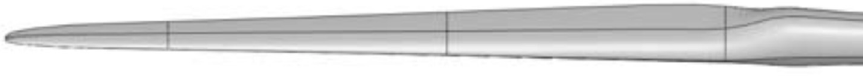
Figure 3. NREL 5MW wind turbine blade [19].